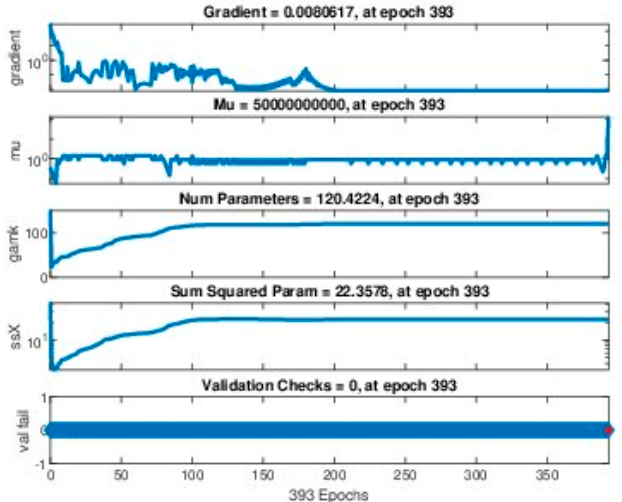
Figure 21. Various training states of neural network (wind velocity forecasting